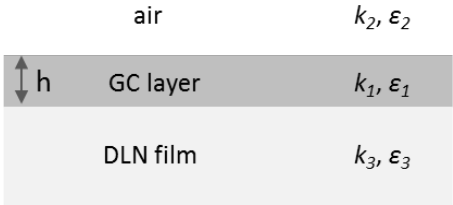
Figure 9. The geometry of a three-layer system used in numerical calculations of the SPP excitation in a thin glassy carbon layer on the DLN film. in a thin glassy carbon layer on the DLN